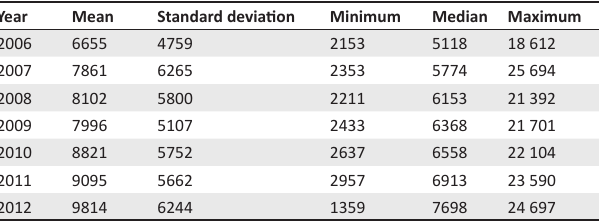
TABLE 2: CEO fixed pay summary (R